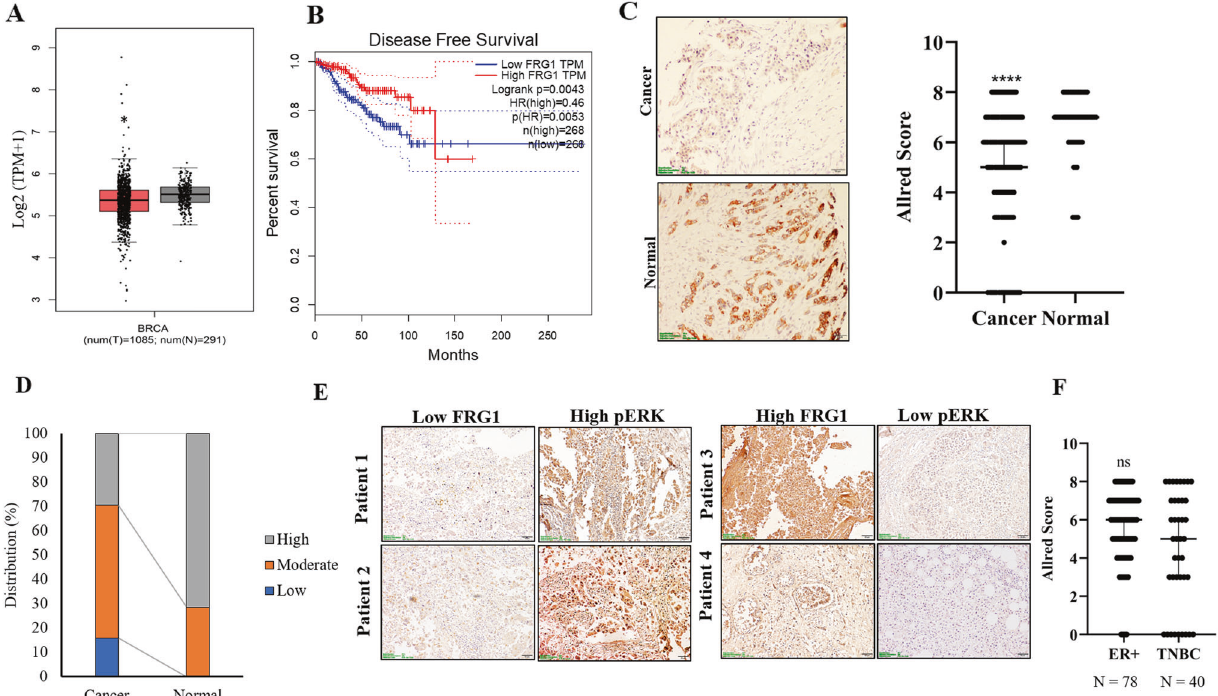
Fig. 6 Low FRG1 is associated with breast carcinogenesis and elevated pERK expression in breast cancer patients. A , B Analysis of RNA sequencing data from TCGA and GTEx databases using GEPIA webserver. A Box plot shows the levels of FRG1 transcripts in cancer ( n = 1085) and normal ( n = 291) samples applying the default parameters p value cutoff 0.01, log 2 FC value cutoff 1, log scale, and jitter size 0.4. B shows the percentage of disease-free survival (RFS) and 95% con fi dence interval in the high FRG1 and low FRG1 expression groups. C Representative IHC images of FRG1 expression in human breast cancer and adjacent normal tissues. The Scatter plot shows the comparison of median Allred scores of FRG1 expression between breast cancer ( n = 194) and adjacent normal ( n = 56) tissues. The difference between the two groups in FRG1 expression was calculated using the Mann – Whitney U -test. D Graphical distribution depicts the frequency of cancer vs. normal tissues according to the Allred score of FRG1. The bar diagram shows the percent distribution of individuals having high, moderate, and low levels of FRG1 in breast cancer patients ( n = 194) and normal tissue samples ( n = 56). The X-axis represents two groups; cancer and adjacent normal. The Y-axis denotes the percentage of individuals having high, moderate, and low levels of FRG1. E Representative images of FRG1 and pERK expression levels detected in breast cancer patients using IHC ( n = 10). F X-axis of the scatter plot shows median Allred scores for the FRG1 level in ER-positive ( n = 78) and TNBC ( n = 40) breast cancer patients. Y-axis denotes the Allred score for the FRG1 expression level. ns, P > 0.05, **** P ≤